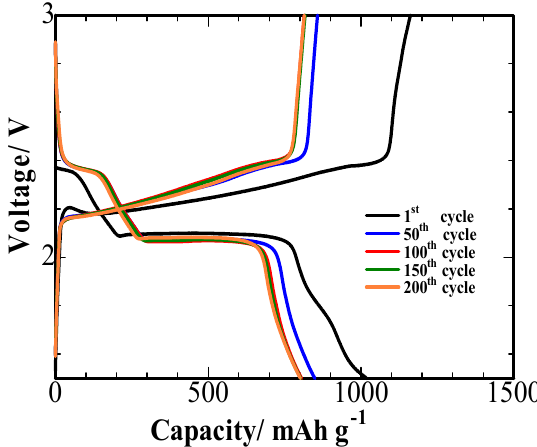
Figure 7. Charge-discharge profiles of S/PPy/PG composite electrode for the 1st, 50th, 100th, 150th and 200th cycles at 0.1 C.